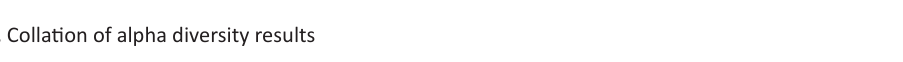
Table 10. Collation of alpha diversity results